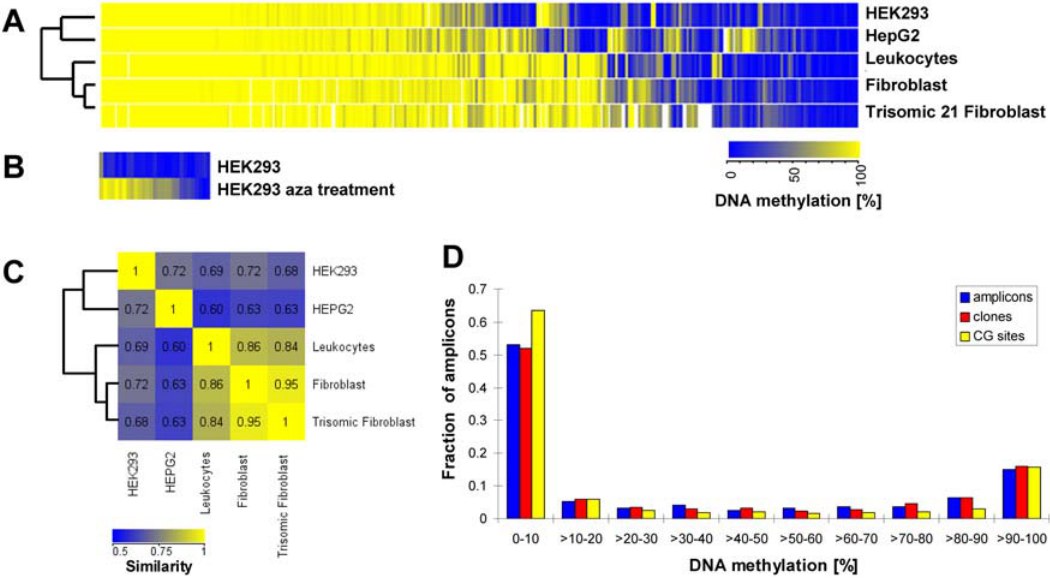
Figure 1. Summary of the DNA methylation data. (A) Clustered heatmap of the DNA methylation levels of all amplicons studied in HEK293, HepG2, leukocytes, fibroblast, and trisomic fibroblast cells, ordered by the average level of DNA methylation and similarity across tissues. (B) DNA methylation levels of selected highly methylated amplicons in HEK293 after treatment of the cell line with 5-azacytidine (for detail, see Text S2). (C) Tissue similarity plot comparing the methylation patterns of all five cell types studied here. The numbers represent pair wise Pearson correlation coefficients between each pair of cell types, calculated using the average DNA methylation levels for all amplicons. (D) Bimodal distribution of the DNA methylation level of all amplicons, clones, and CpG